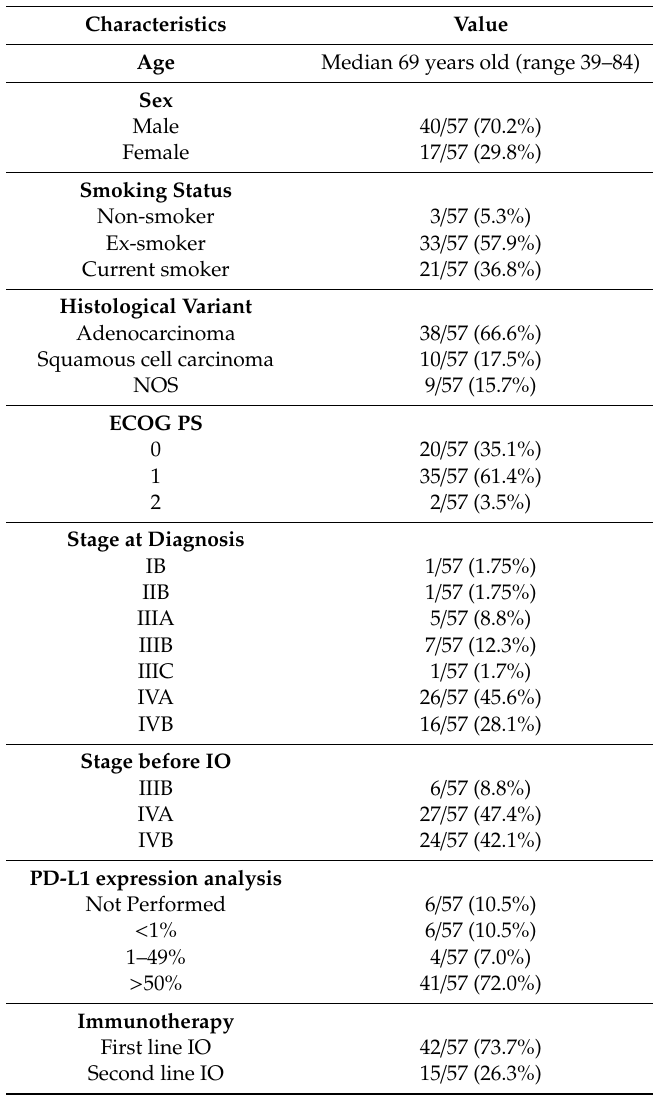
Table 1. Overall population ( n = 57)